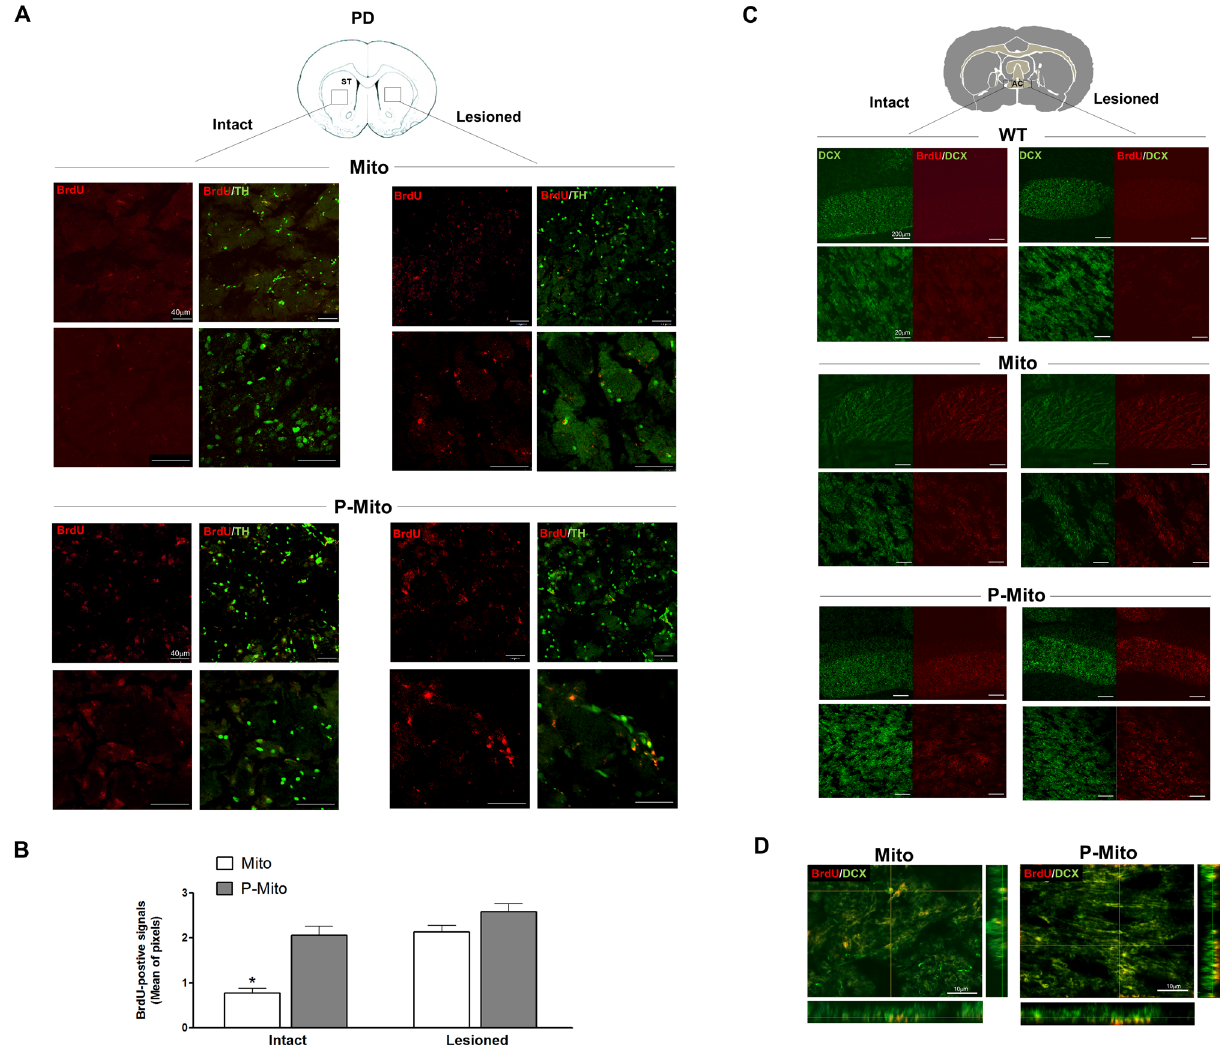
Figure 7. BrdU-labeled mitochondria were expressed in striatal DA neurons and DCX-positive neurons of the anterior commissure (AC), defined by cross-sectional areas of the forebrain. ( A ) Double immunofluorescent staining of BrdU (red) with TH (green) was performed to confirm intranasally administered mitochondria in striatal DA neurons and ( B ) BrdU signals were quantified individually in lesioned and contralateral (intact) sides using ImageJ Software. ( C ) Reconfirmation of contralateral delivery of mitochondria employed double immunofluorescent staining, using BrdU (red) with DCX antibody (green) in the intact and lesioned sides of the AC, a bundle of axons connecting the two cerebral hemispheres. Images were taken at different magnifications in each group. ( D ) The merged image of Z-Stack confocal images, shown as side views of the x–z and y–z planes, revealed the localization of exogenous mitochondria in DCX-positive neurons. * P < 0.05, vs. Lesioned side, WT wild-type controls, Mito mitochondrial alone, P-Mito Pep-1-labelled